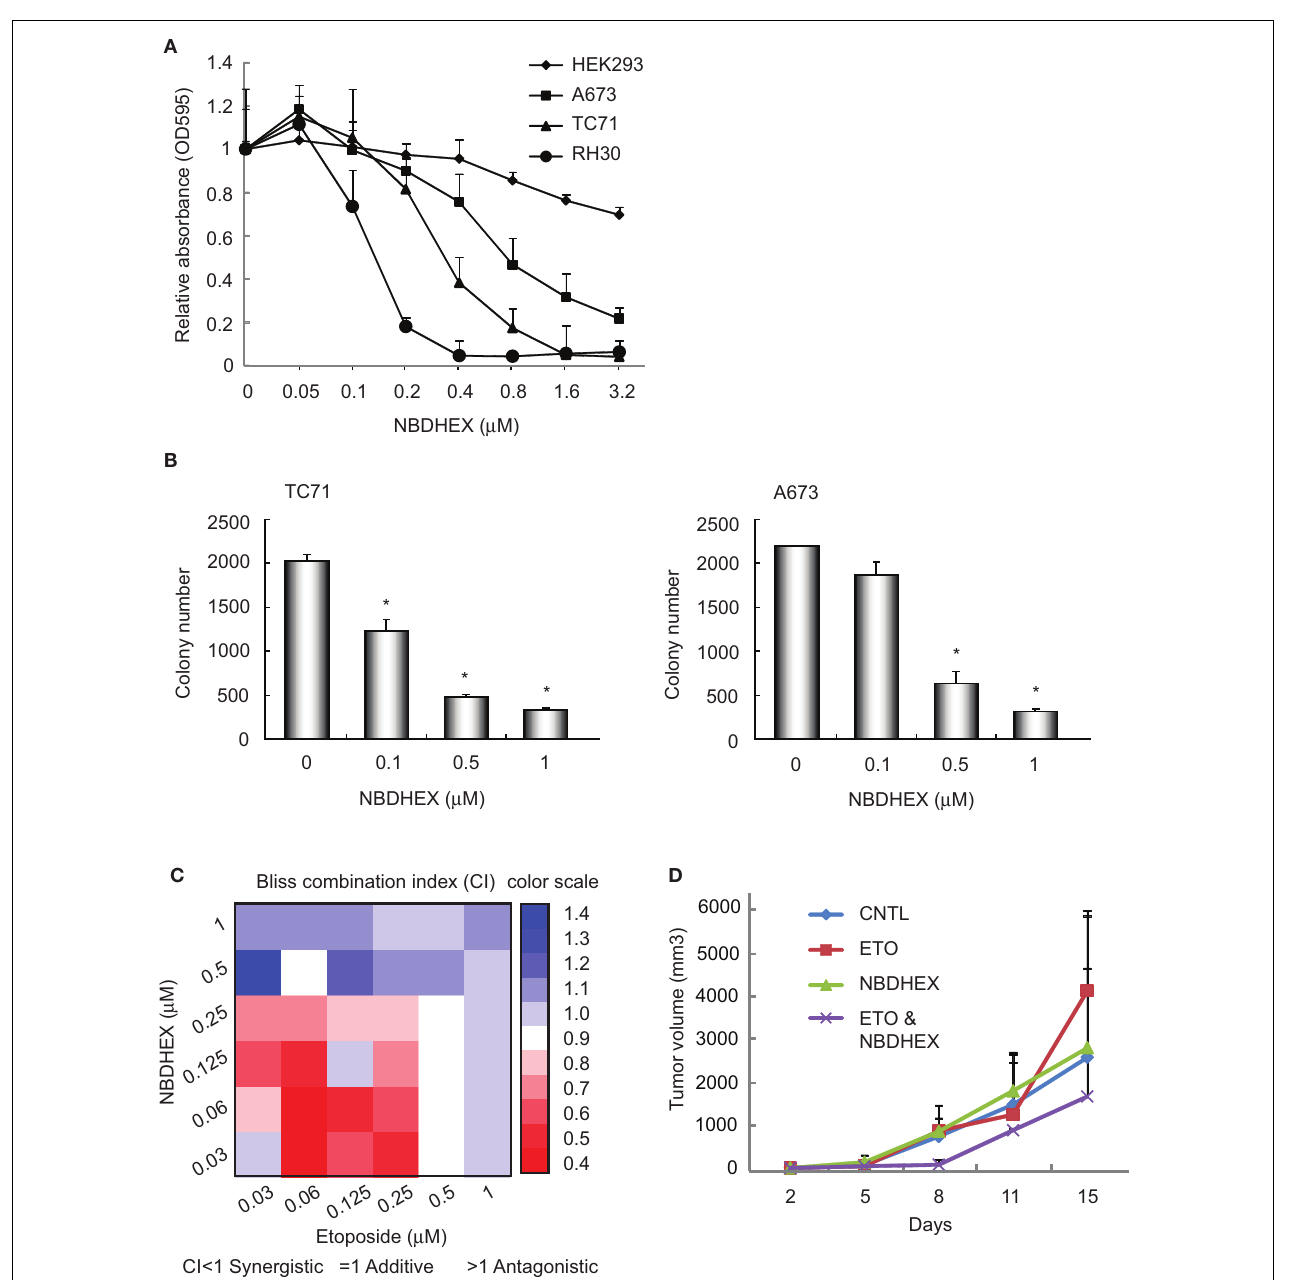
FIGURE 2 |The GST inhibitor NBDHEX inhibits Ewing sarcoma cell proliferation and oncogenic transformation and increases the efficacy of etoposide . (A) , NBDHEX inhibits Ewing sarcoma cell growth in culture. Ewing sarcomaTC71 and A673 cells, rhabdomyosarcoma RH30 cells, and HEK293 cells were subjected to treatment with the indicated concentrations of NBDHEX. Cell proliferation was assessed by MTT assays. The experiment was repeated three times and results of one representative repeat are shown as means ± SD of technical triplicate. (B) NBDHEX inhibits colony formation of Ewing sarcoma cells in soft agar.TC71 and A673 cells were treated with NBDHEX at the indicated concentrations, and then were seeded in soft agar to assess anchorage-independent growth.The experiment was repeated three times and results of one representative repeat are shown as means ± SD of technical duplicate. Asterisk indicates p < 0.05. (C) NBDHEX and etoposide act synergistically in inducing